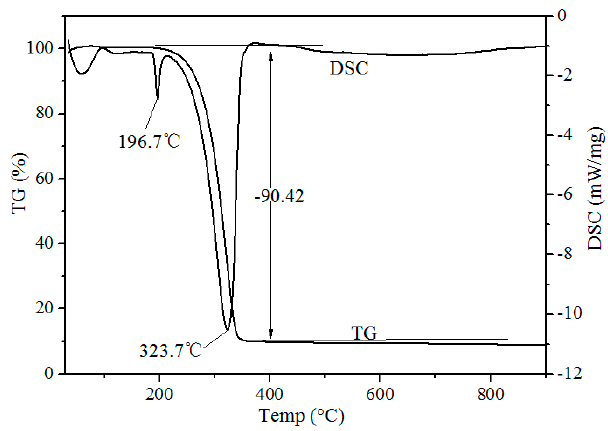
Figure 3. TG–DSC curves of waste phosphors mixed with NH 4 Cl ( m (ore): m (NH 4 Cl) = 1:4).